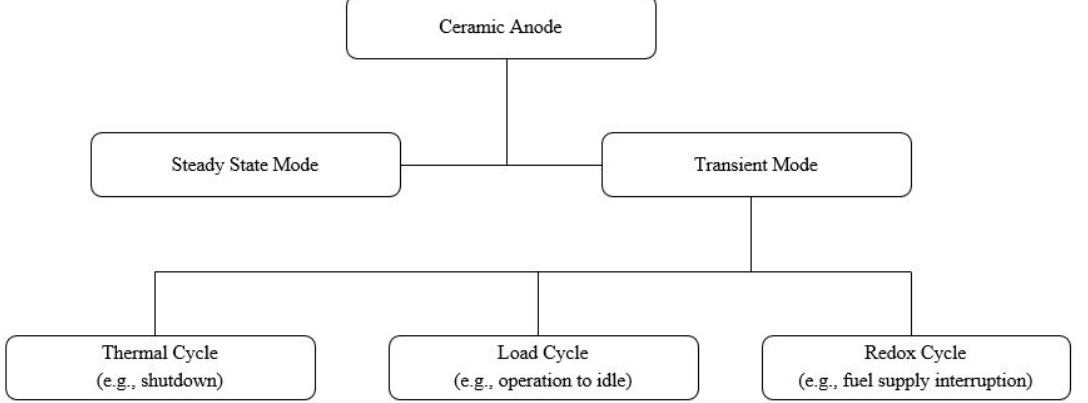
Figure 2. Operating conditions of SOFCs.